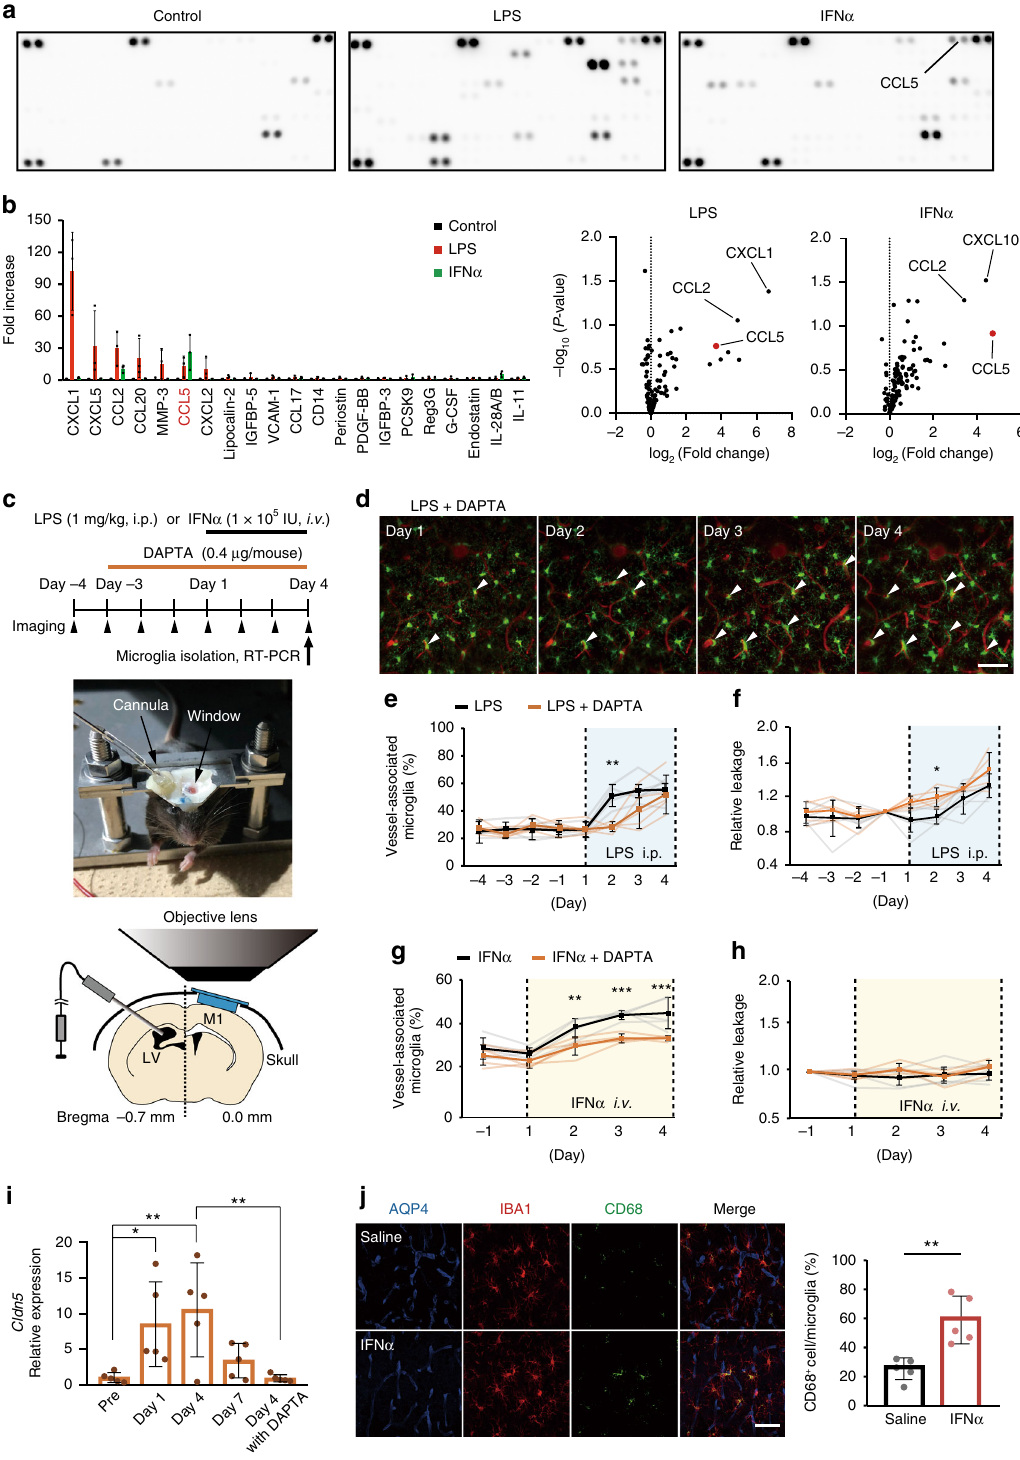
under the same dosing schedule. To produce a milder LPS model, we also prepared a single LPS injection model (1.0mg/kg, i.p., one shot throughout the experiment). The Iba1-tTA::tetO-DTA mice were reared with chow containing Dox 100 mg/kg. Withdrawal of the doxycycline (Dox-Off) in the feed induced selective expression of the diphtheria toxin A (DTA) in microglia, resulting in cell death. The Dox-containing chow was replaced by Dox-free standard chow 7 days before starting two-photon imaging during the consecutive 7-day LPS injections. Minocycline hydrochloride (Mino; M9511-1G; Sigma-Aldrich, St. Louis, MO) was administered to inhibit microglial activation. Single daily injections of Mino (75 mg/kg, i.p.) were started 3 days prior to LPS injections and continued